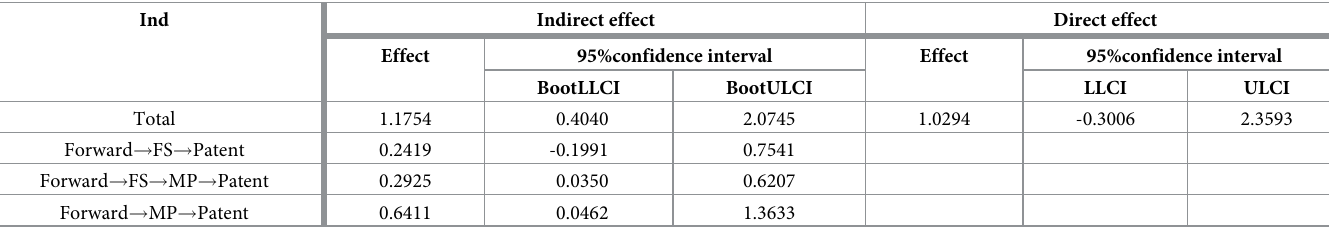
Table 6. Chain intermediary test of financing structure and market power with forward integration.